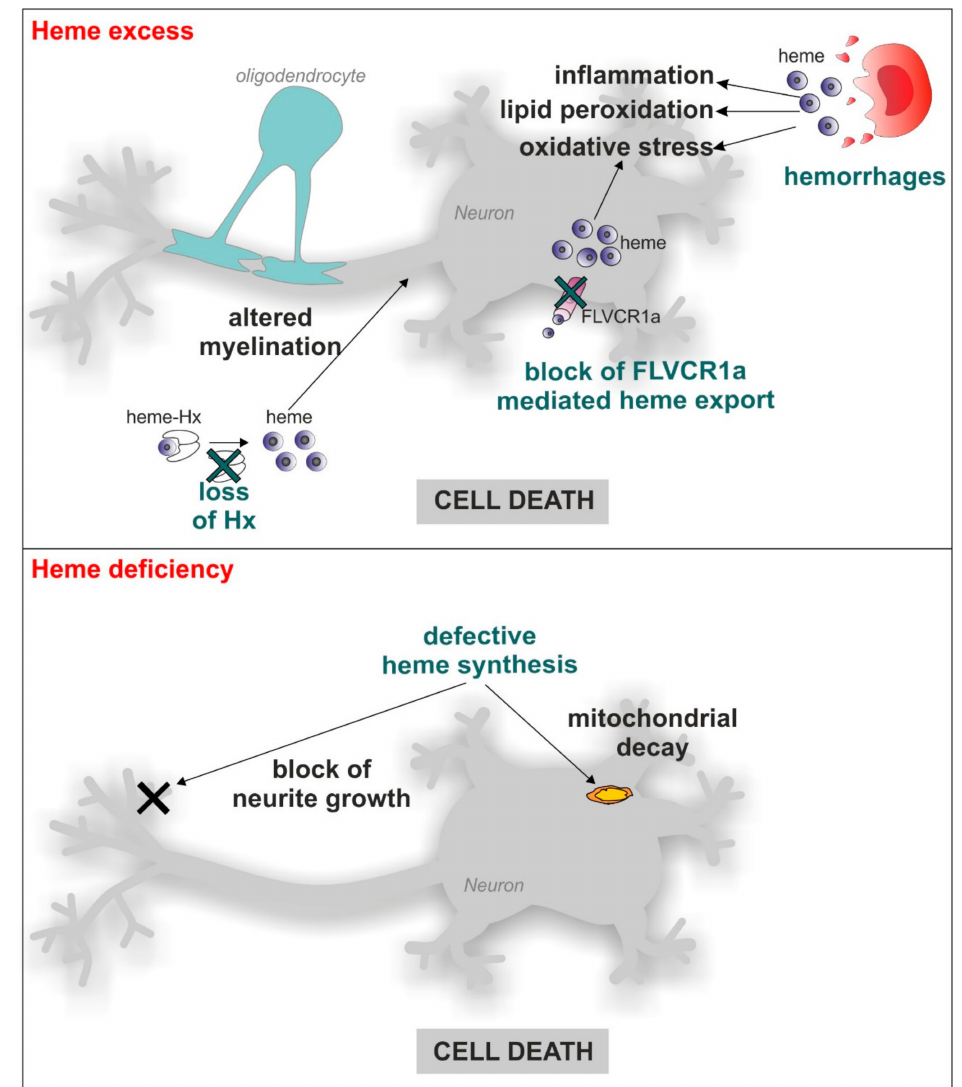
Figure 1. Implication of heme in neurodegeneration. Both heme excess and heme deficiency contribute to neurodegeneration. Heme released during hemorrhages leads to inflammation, lipid peroxidation and oxidative stress; the loss of the heme scavenger Hx causes defective myelination of axons; the impairment of intracellular heme export by FLVCR1a is associated with increased oxidative stress. On the other hand, heme deficiency, due to defective synthesis, leads to mitochondrial decay and the blocking of neurite growth. These events all result in neuronal cell death. In the figure, neurons are represented as the main target for heme-mediated effects; however, other cell types of the nervous system could be affected by the same